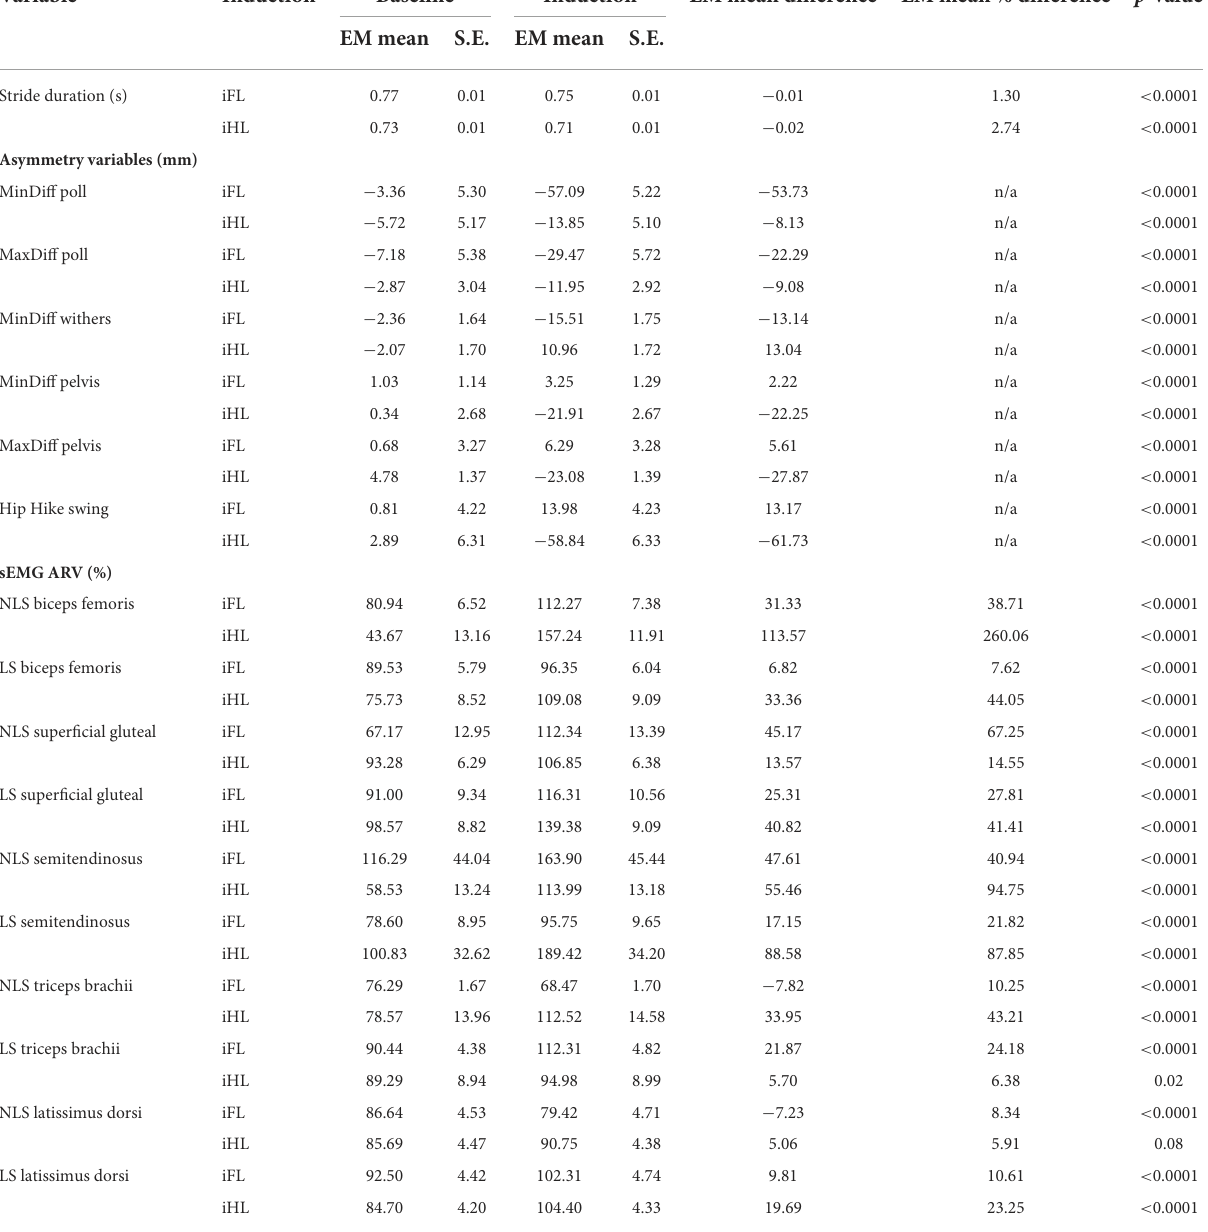
TABLE 1 Estimated marginal means (EM Mean) and standard error (S.E.) for baseline and lameness induction conditions, and estimated differences (EM Mean Difference, EM Mean % Difference) between corresponding baseline and induction conditions and associated p -values for discrete stride duration (s), asymmetry variables (mm), and sEMG ARV variables